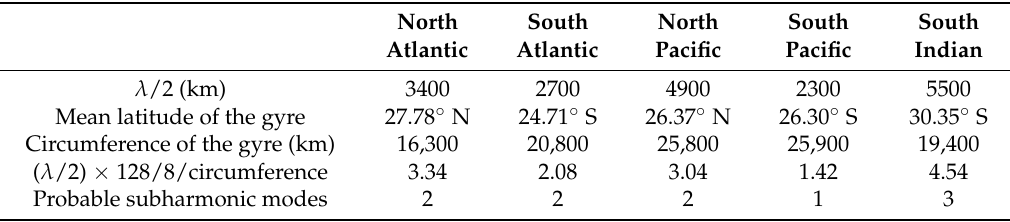
Table 1. Subharmonic modes of 128-year period Gyral Rossby Waves (GRWs). λ /2 is the estimated apparent half-wavelength of 8-year period GRWs [14].